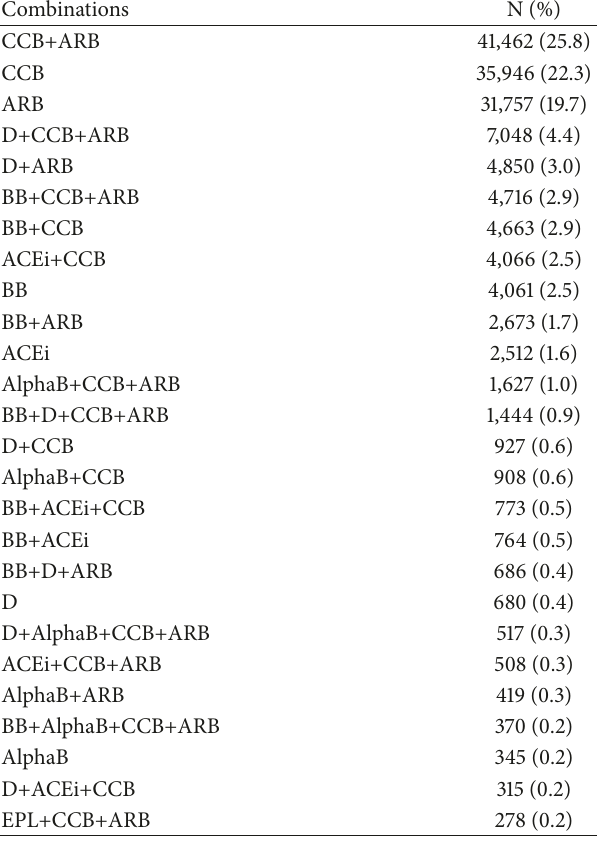
Table 3: Combinations of antihypertensive drugs in order of frequencyinallpatientswhoreceivedantihypertensivedrugsduring the last claim month of stable treatment ( ≥ six months of treatment with the same drugs; combinations with 0.2% or more are shown).